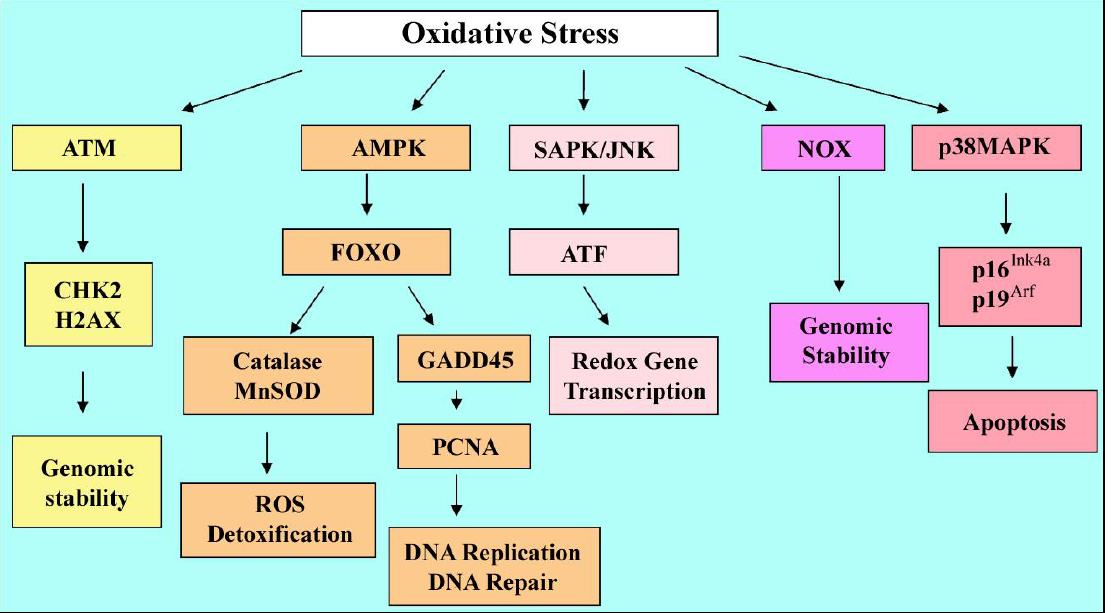
Figure 5. Oxidative stress and adaptive responses. Genomic stability mediated by ATM is promoted through activation of cell cycle inhibitor checkpoint kinase 2 (Chk2) and DNA damage response protein and histone variant H2AX. FoxO family regulates ROS detoxification and DNA repair by Catalase, MnSOD and GADD45 that lead to cell survival. Under stress conditions, the NOX enzyme may be induced and result in increased ROS production and genomic instability. Under higher levels of ROS, cycle inhibitors p16 Ink4a and p19 Arf may become upregulated through p38 MAPK which promote apoptosis of damaged